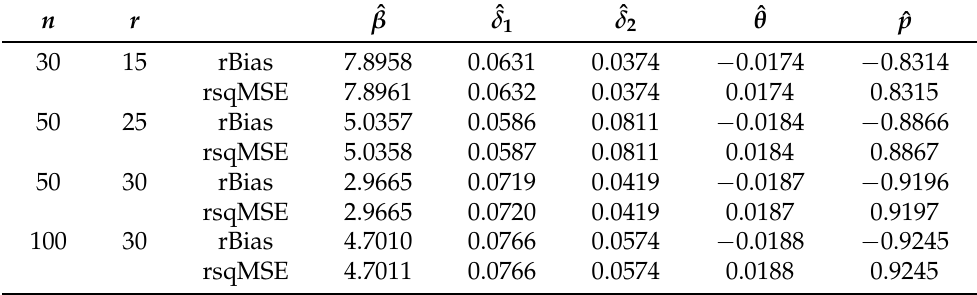
Table 7. The rBias and rsqMSEs of MLEs for p = 0.3.